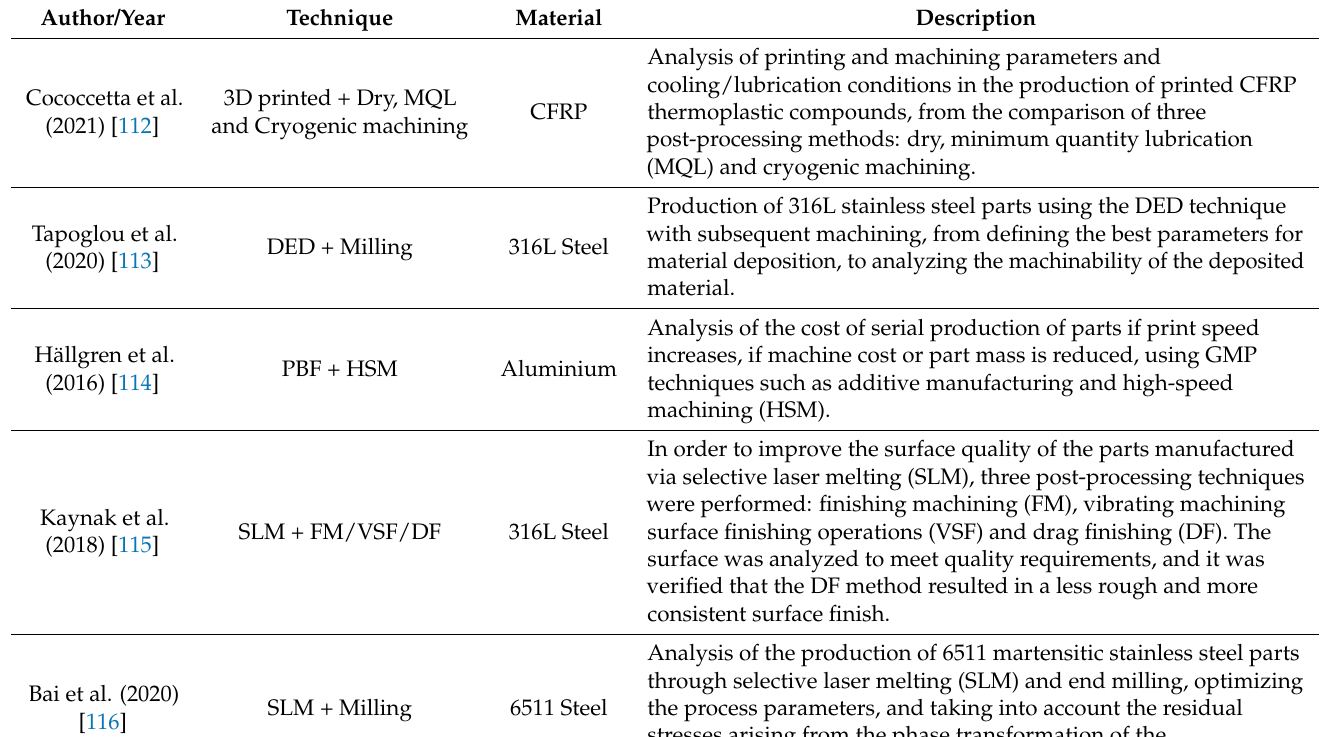
Table 1. Summary of studies about hybrid manufacturing, coupling addictive processes and